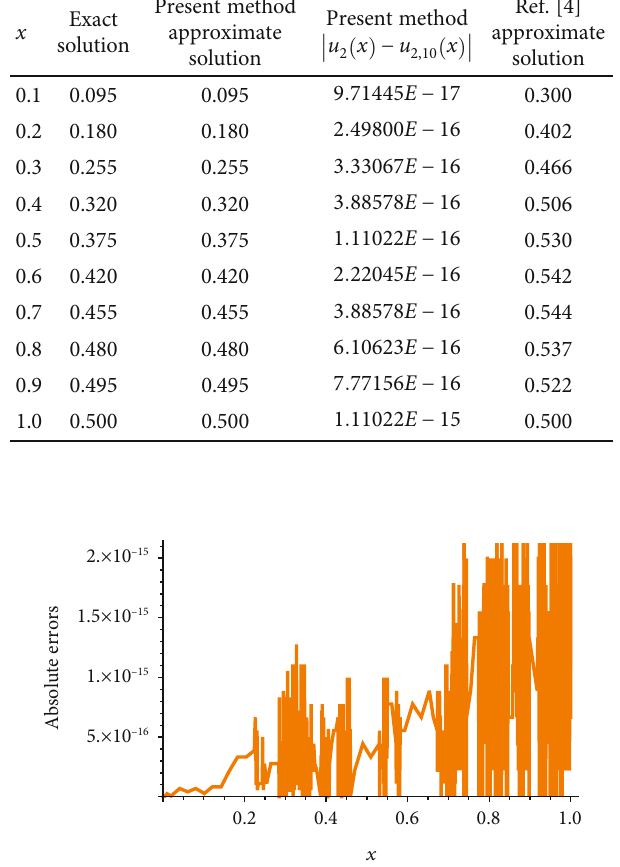
x Þ in Example 3. 2 ð